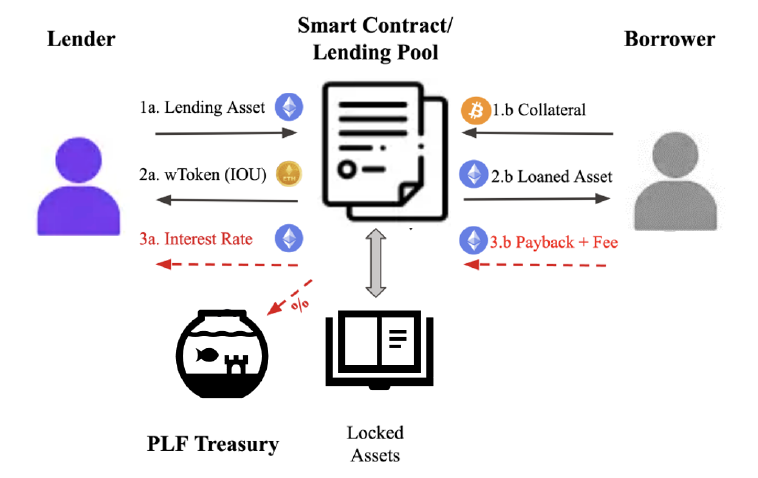
Figure 1. Lending protocol framework [26].